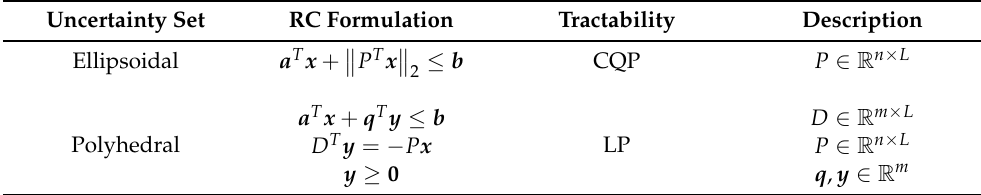
Table 1. RC reformulation for ellipsoidal and polyhedral uncertainty